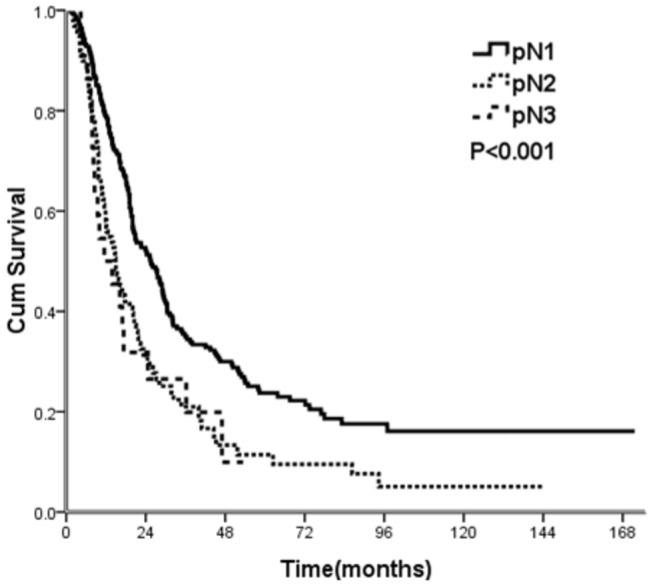
Cumulative survival of patients stratified by the number of lymph node metastases (pN).